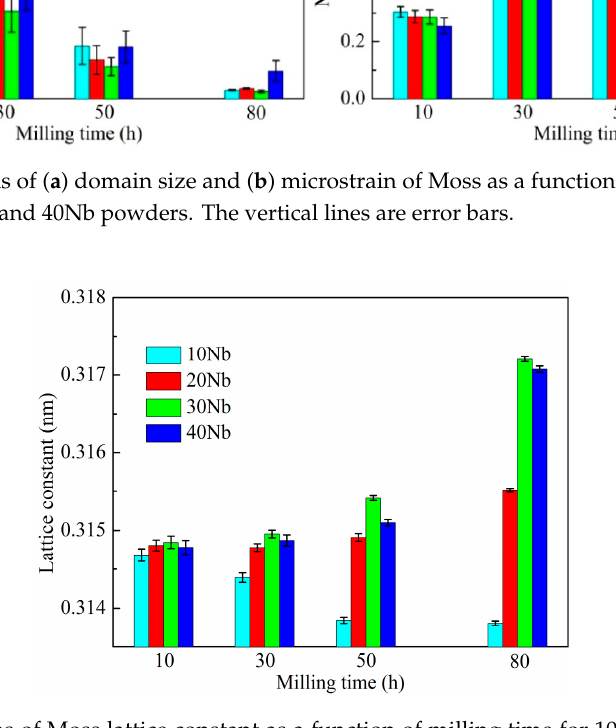
Figure 5. Evolutions of Moss lattice constant as a function of milling time for 10Nb, 20Nb, 30Nb, and 40Nb powders. The vertical lines are error bars.